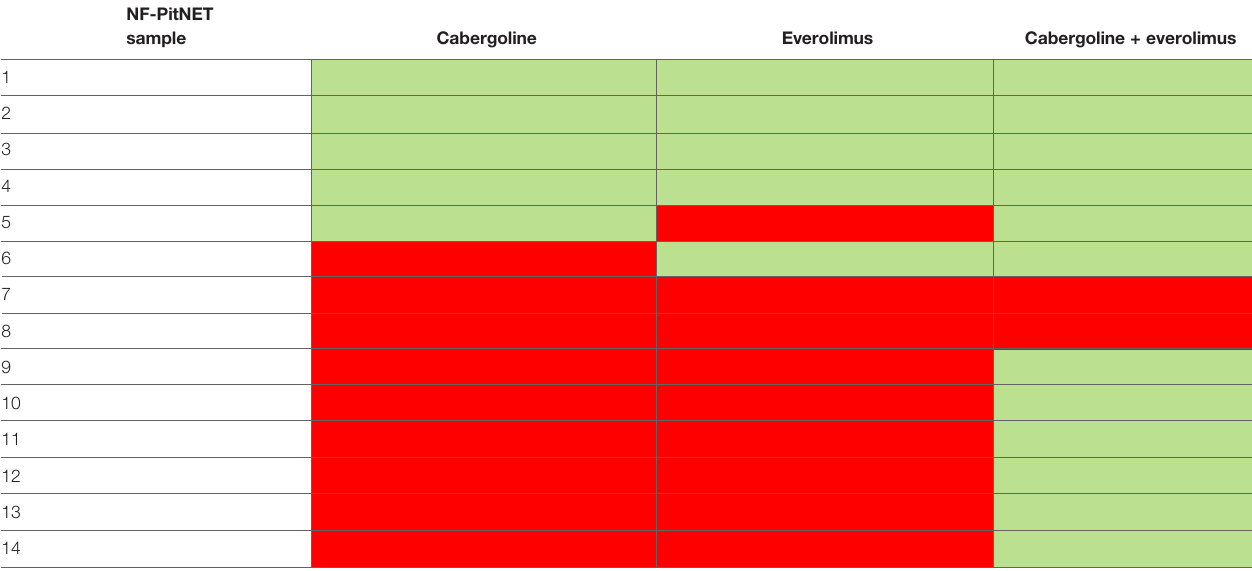
TABLE 2 | NF-PitNETs primary cultured responsiveness to everolimus, cabergoline, and their cotreatment. NF-PitNET sample